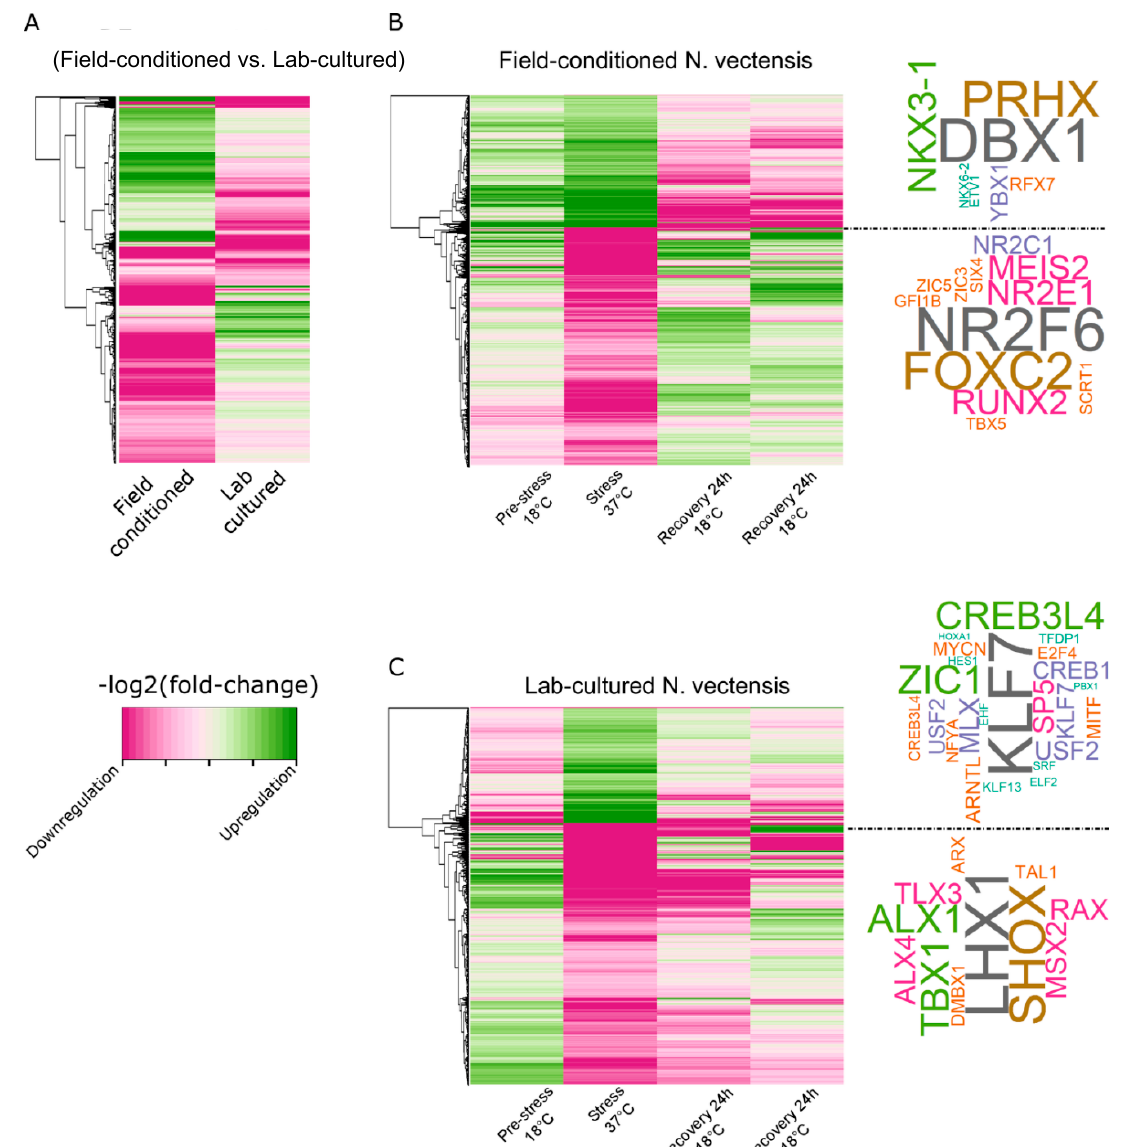
Figure 3. Rearing conditions affect TF enrichment and transcriptional response during heat exposure. ( A ) DE gene profile ( n = 3332 genes obtained from both groups) at the stress time point relative to the corresponding pre-stress time point (3-h at 37°C). ( B , C , Left) Heatmaps of [–log 2 (fold-change)] of RNA expression of N. vectensis genes from field-conditioned ( B , n = 2572) and lab-cultured ( C , n = 887) groups. ( B , C , Right) Word clouds clustering names of transcription factors most significantly enriched in accessible chromatin (ATAC-seq) within promoters of differentially expressed genes (RNA-seq stress vs. pre-stress